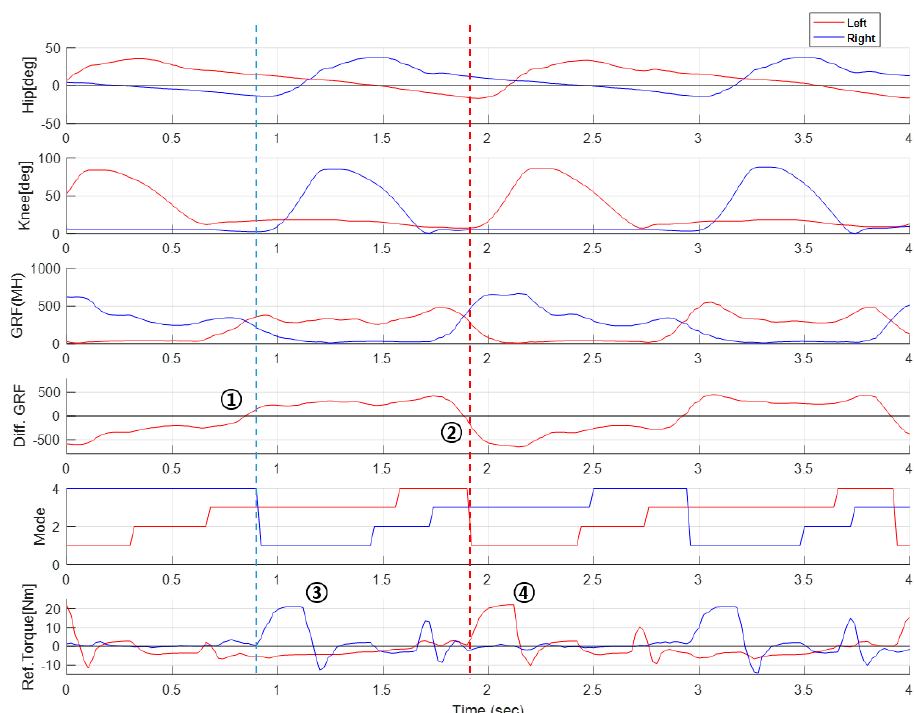
Figure 10. The control and sensor data from the walking test. Shown are the data collected for 4 s in the walking test with the knee output torque set at 100% level: Numbers ➀ and ➁ represent the point at which the left and right gait transitions from stance to swing based on GRF differential signal from the left and right sides. Numbers ➂ and ➃ represent knee flexion and extension torque output in the swing sections of the left and right sides.